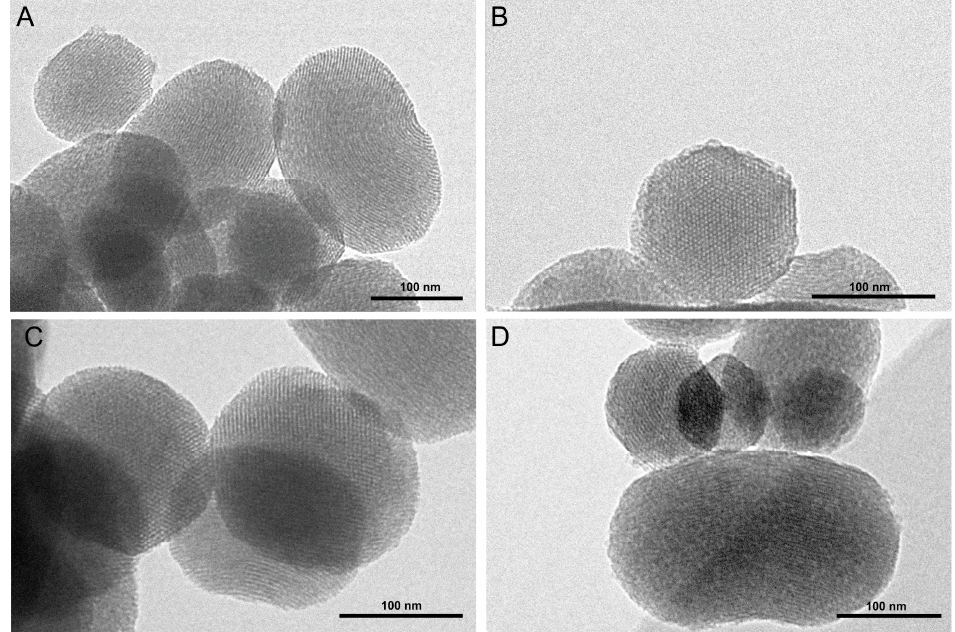
Figure 2 . ( A ) SAXS patterns and ( B ) Adsorption/desorption N 2 of MSN, MSN − Cl, MSN − TETA samples. Table 1. Surface area (S BET ), pore volume (V p ), lattice spacing ( a ), zeta potential ( ζ ) and functionalization loadings (L) of MSN, MSN-Cl and MSN-TETA samples. Sample